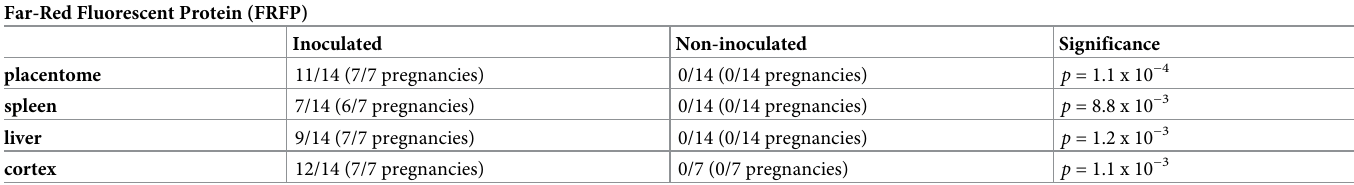
Table 5. PCR amplification of plasmid DNA encoding far Red Fluorescent Protein (FRFP). Data representation and data analysis are as described in Table 3. Far-Red Fluorescent Protein